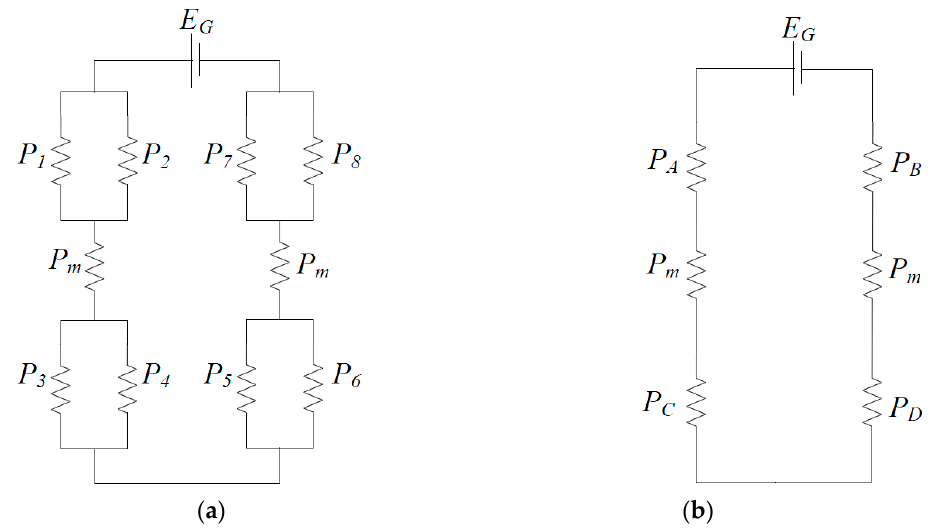
Figure 7. Equivalent and simplified magnetic circuit of DSSR-PMG, ( a ) Equivalent magnetic circuit; ( b ) Simplified magnetic equivalent circuit.